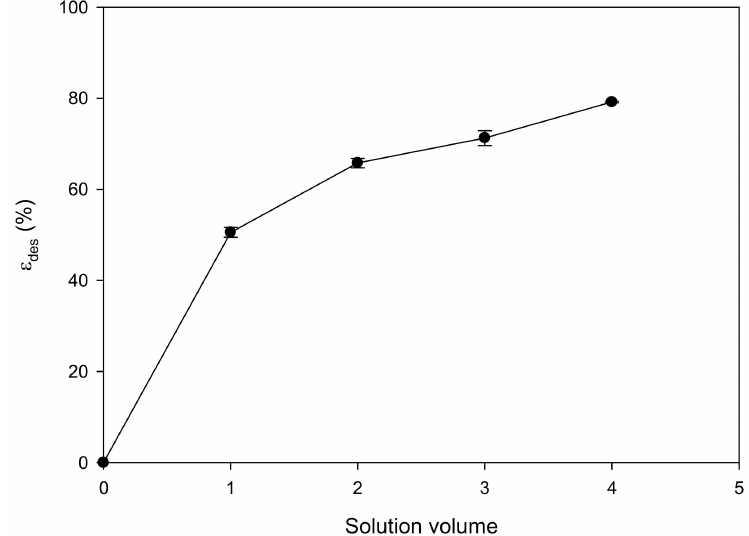
Figure A8. The desorption efficiency of Zn(II) ions changing the desorption solution for fresh EDTA/NaOH 0.5 N